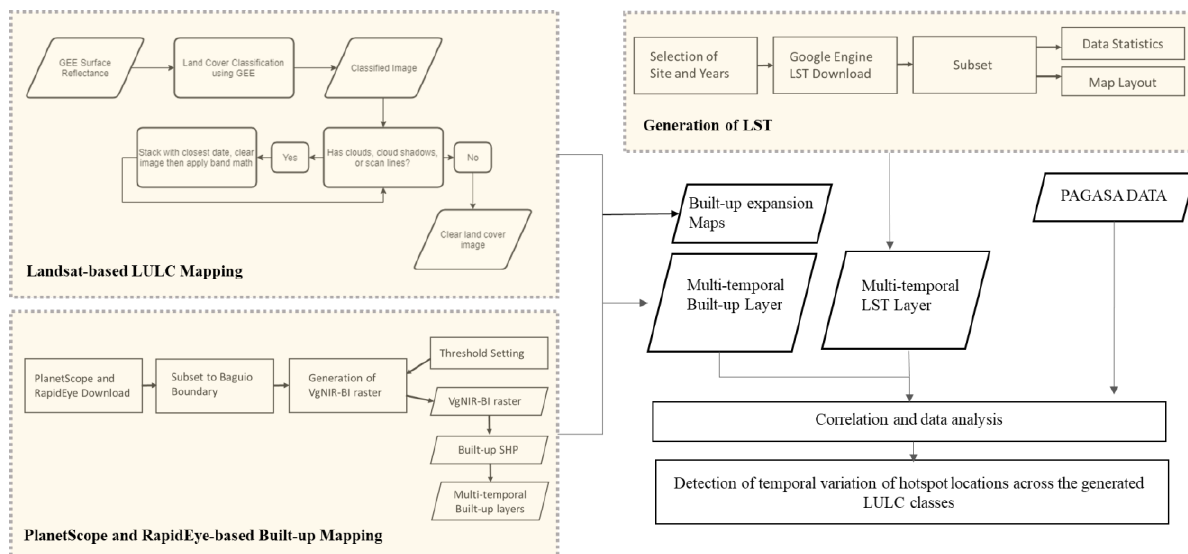
Figure 2. General research workflow divided into urban extent mapping, land and air temperature generation, and data